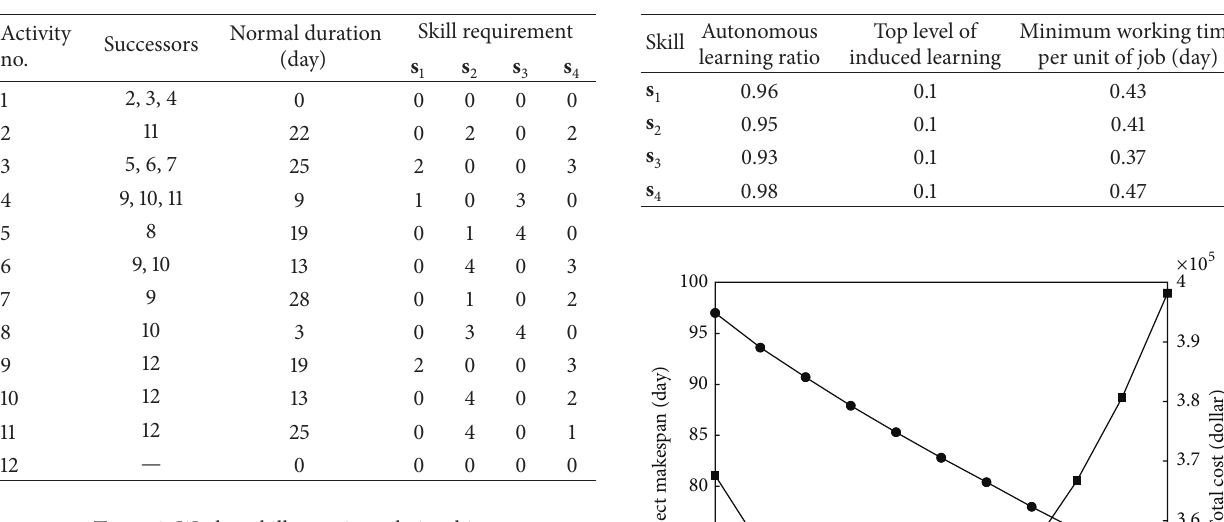
Table 2: Worker-skill mapping relationships. Worker